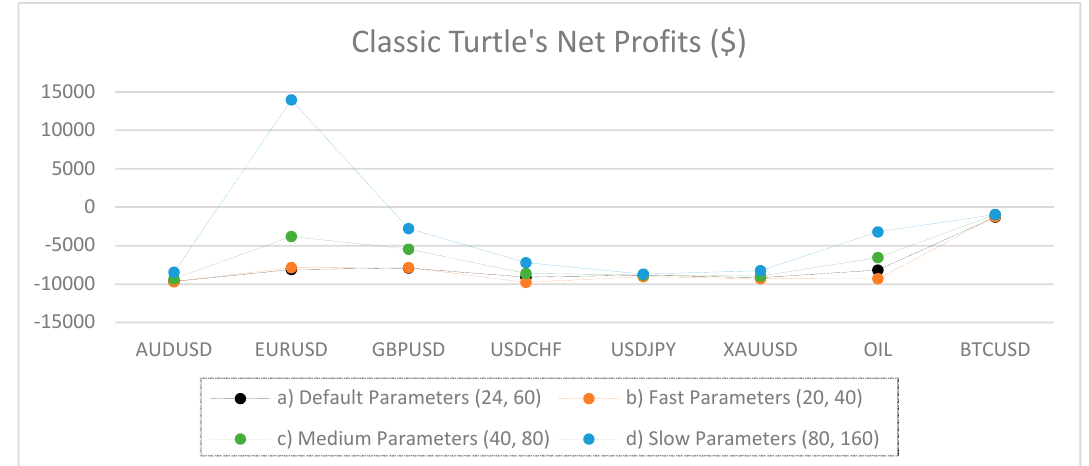
Figure 7. Net profits for experiments (a), (b), (c) and (d).